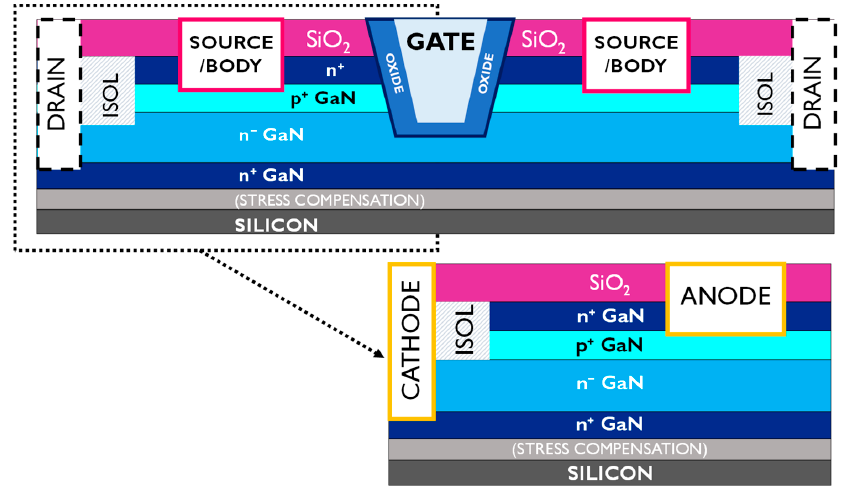
Figure 1. Schematic of the p + n − diode test vehicle structures, the fundamental unit of a complete semi-vertical MOSFET.